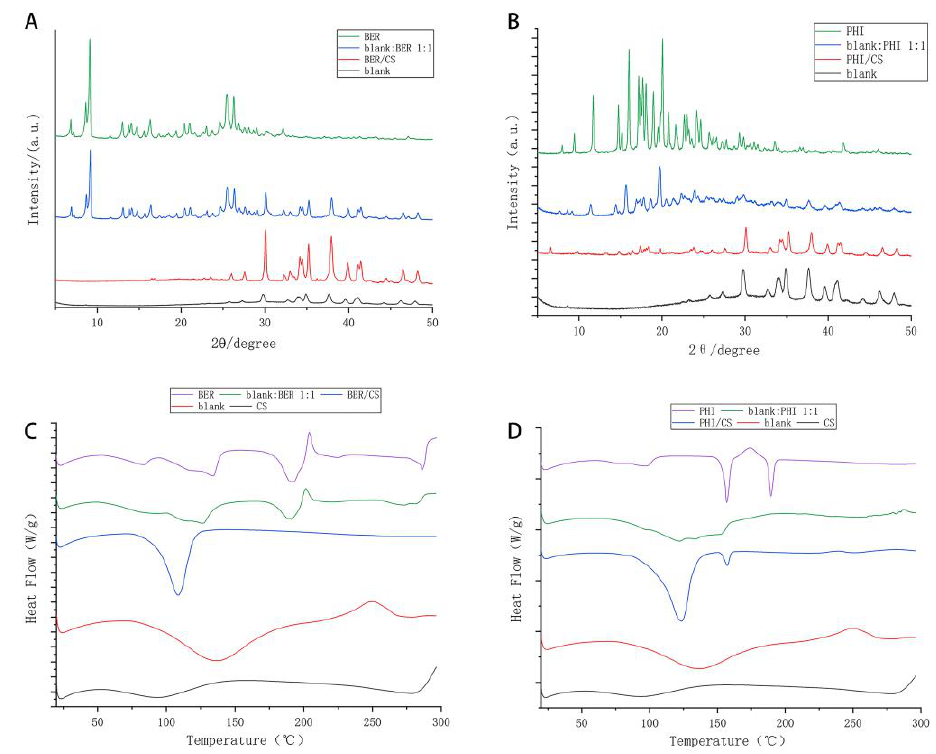
Figure 3. PXRD patterns and DSC patterns of BER/CS and PHI/CS. ( A ) The PXRD patterns of BER, blank CS precipitates without bitter drugs (blank), a physical mixture of BER and blank with a mass ratio of 1:1 (blank:BER 1:1), BER/CS; ( B ) PHI, blank, 1:1 blank:PHI 1:1, PHI/CS; ( C ) the DSC results of BER, blank:BER 1:1, BER/CS, blank and CS are given in this figure; and ( D ) PHI, blank:PHI 1:1, PHI/CS, blank and CS.